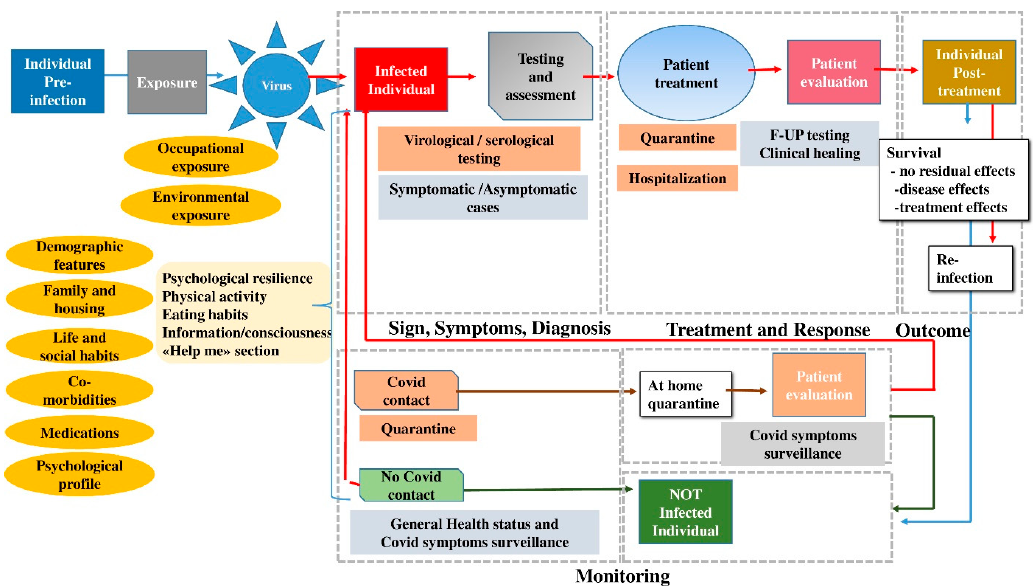
Figure 1. Doing Risk sElf-assessment and Social health Support for COVID (Dress-COV) conceptual